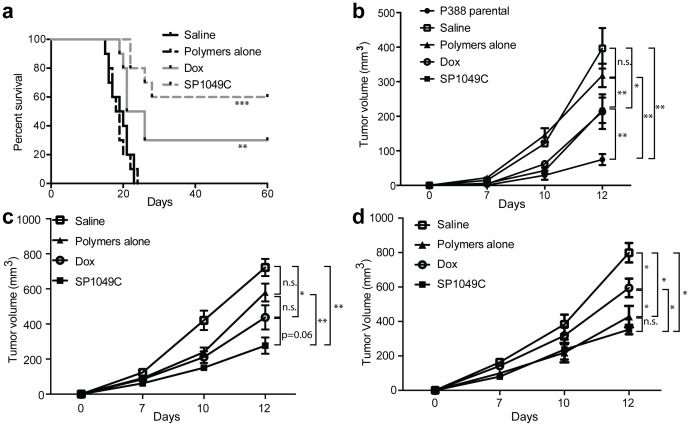
SP1049C treatment decreases tumor aggressiveness.(a) Lifespan of animals injected with (5×103 cells) cells from Passage 6 (n = 10/group); (b, c, d) Rate of s.c. tumor growth of P388 ascitic cells after different chemotherapy treatment regimens (5×105 cells/mice from (b) Passage 1, (c) Passage 4 and (d) Passage 7 were s.c inoculated and tumor volumes measured every other day (n = 5/group)). Data presented as average ± SEM. (a) Survival curves were compared to the saline group using the log-rank (Mantel-Cox) test; (b,c,d) tumor volumes comparisons are presented for day 12 data point; the comparisons were made using Student’s t-test. *p<0.05, **p<0.01, ***p<0.001, n.s. – not significant.